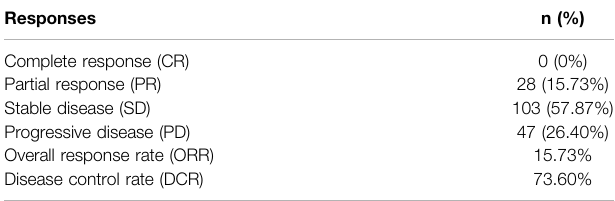
TABLE 2 | Ef fi cacy of apatinib in patients ( n =